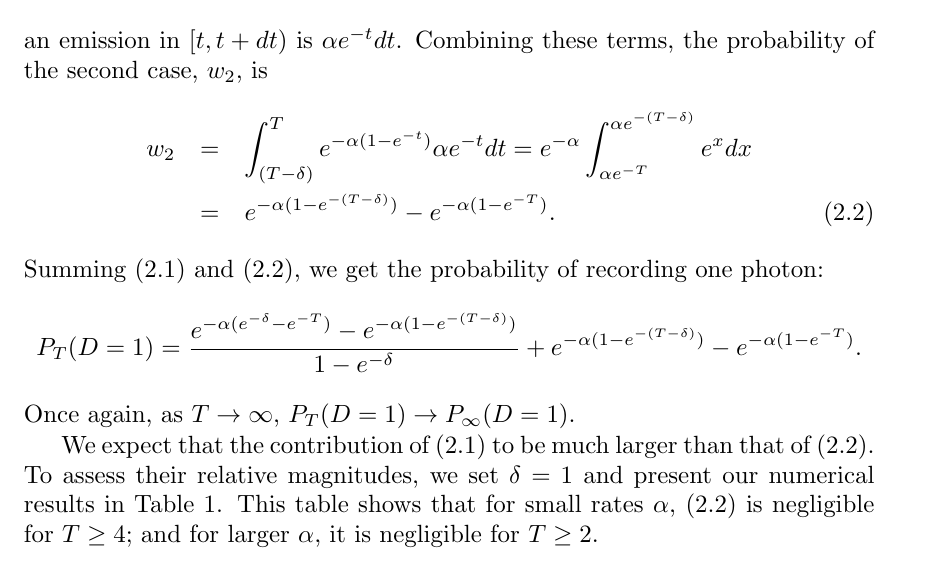
Table 1. Comparison of (2.1) with (2.2) α Eq. T=2 T=4 T=6 T=8 T=10 (2.1) 0.5